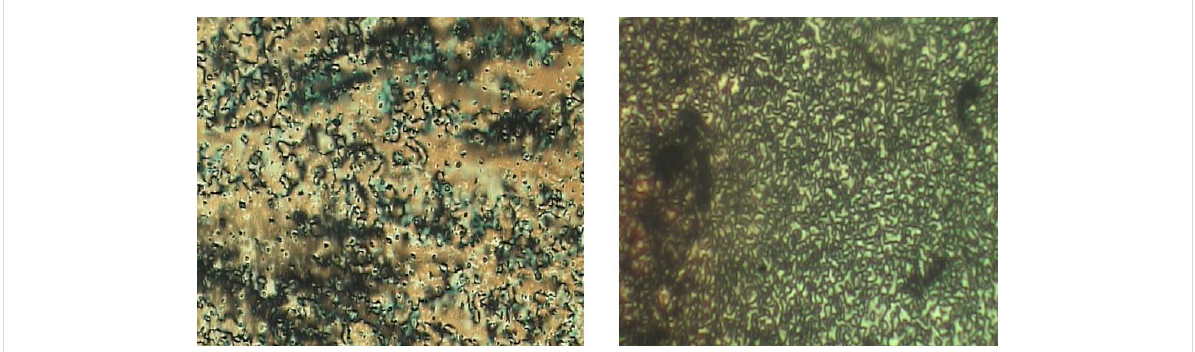
Figure 14: Left: POM image of ligand 12 . Right: POM image of Schlieren texture of the hybrid Au@12 . Reprinted with permission from [69]. Copy- right 2006 American Chemical Society.